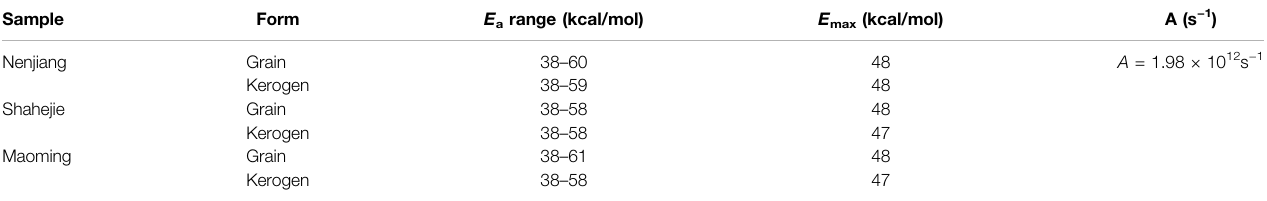
TABLE 2 | Kinetic parameters obtained from Rock-Eval pyrolysis for grains and kerogen from NJZ shale, SHJ shale, and MM oil shale. Sample